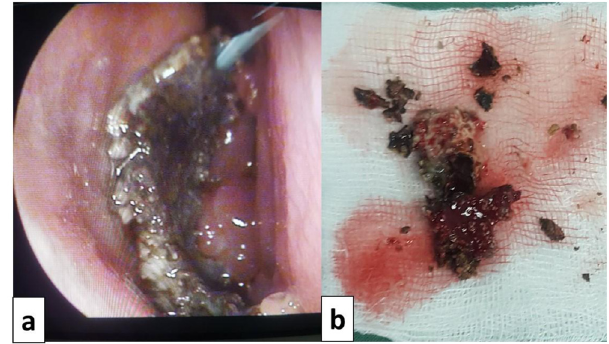
Figure 4. Intraoperative view of a case of fungal ball: a : fungal ball taken from the left maxillary sinus. b : fungal ball